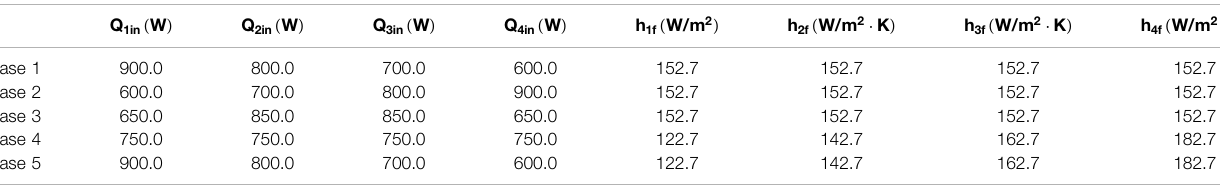
TABLE 3 | Description of a non-uniform heat transfer boundary